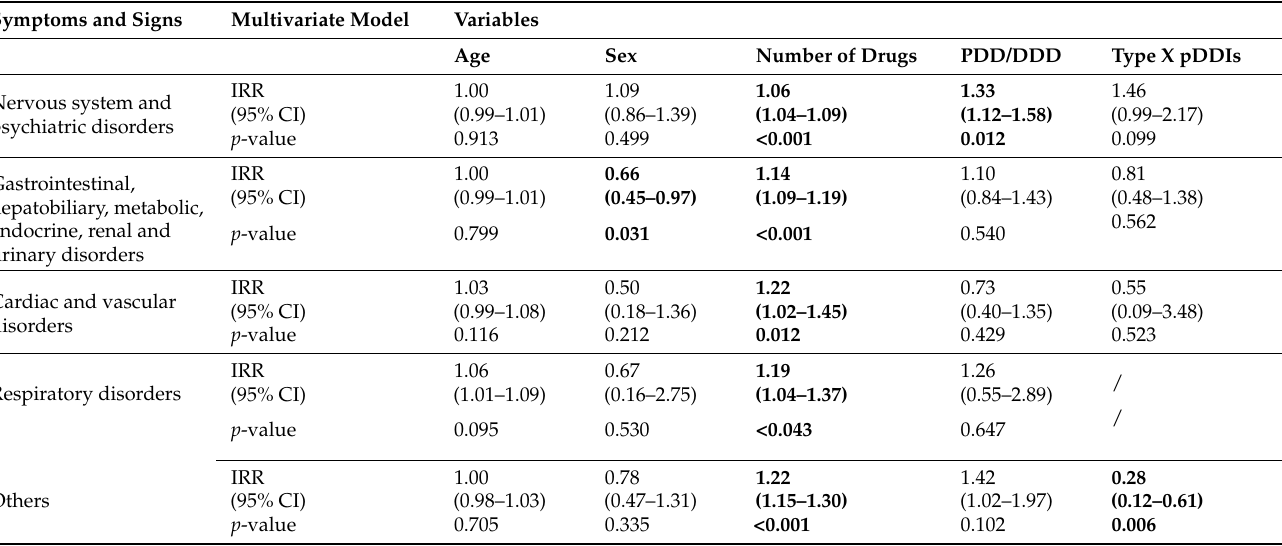
Table 4. Poisson regression analysis based on exposure to clinically observed symptoms and signs for patients in group 1 and 2 (n =